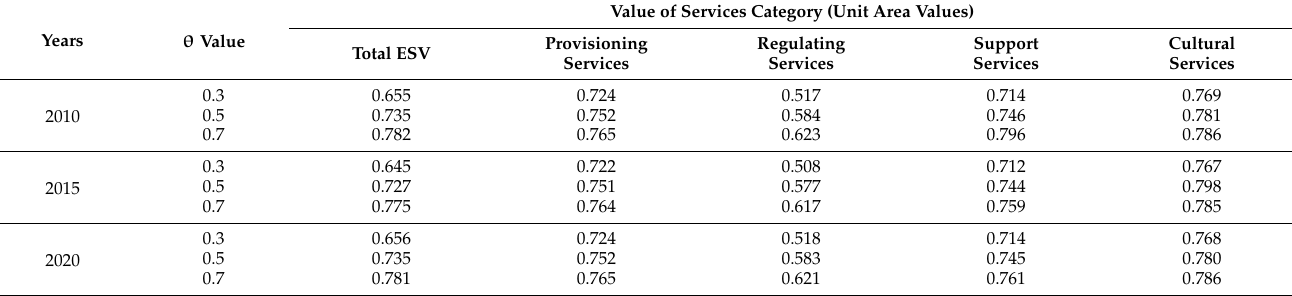
Table 7. Grey relational degree between ESV and ER